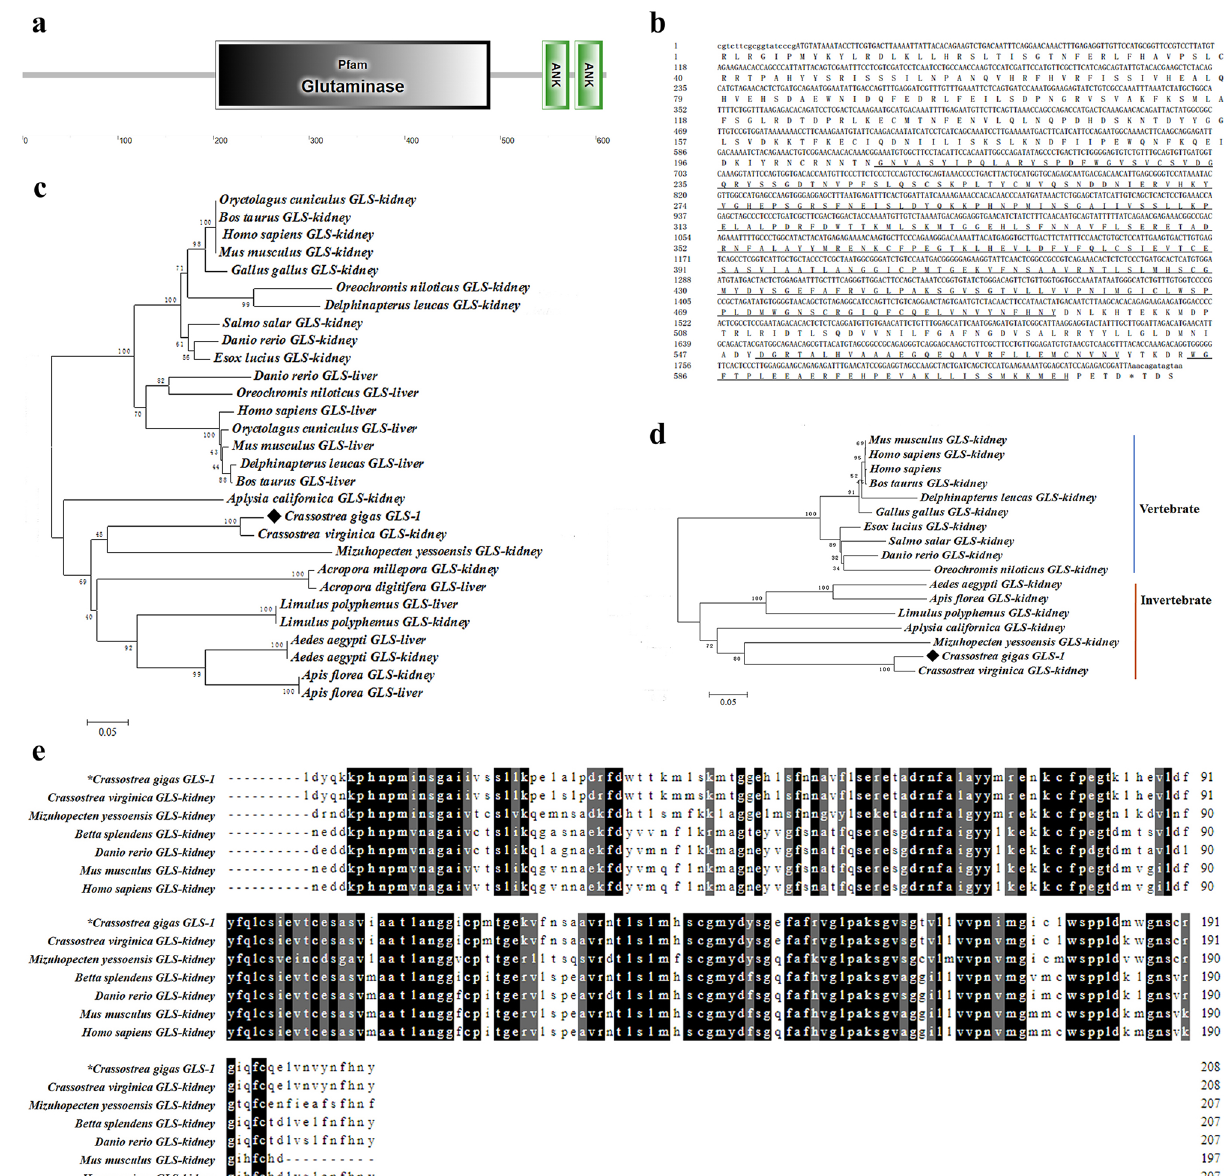
Figure 1. The sequence characteristics of Cg GLS-1. ( a ) The structure of Cg GLS-1 predicted by SMART. Cg GLS-1 protein contains a Glutaminase domain (202–489 aa), and two ANK domains (544–607 aa). ( b ) The ORF of Cg GLS-1. The GLS domain and ANK domains are underlined. ( c , d ) The Neighbor-joining (NJ) phylogeny tree of GLS-1 from various species including vertebrates and invertebrates. The information of sequences used for the Cg GLS-1 phylogenetic analysis was shown in Table 2. The bootstrap value is displayed by the numbers at the forks. ( e ) Multiple sequences alignment of Cg GLS-1 with other GLS from vertebrates and invertebrates. The black shadow region indicates positions where all sequences share the same amino acid residue. Similar amino acids are shaded in grey. The information of sequences used for the Cg GLS-1 alignment is shown in Table